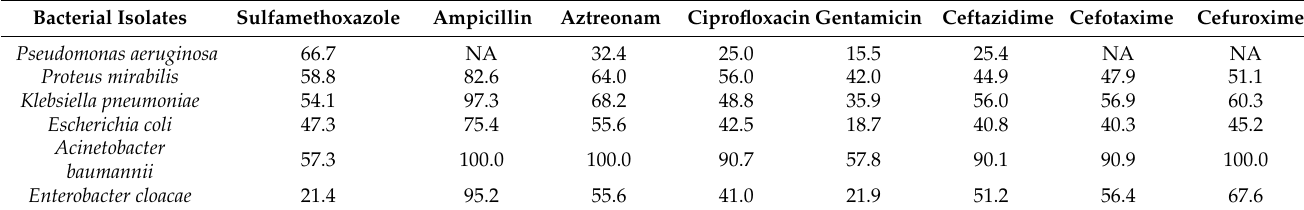
Table 5. Gram-negative bacterial resistance rates in patients aged 48–63 years.